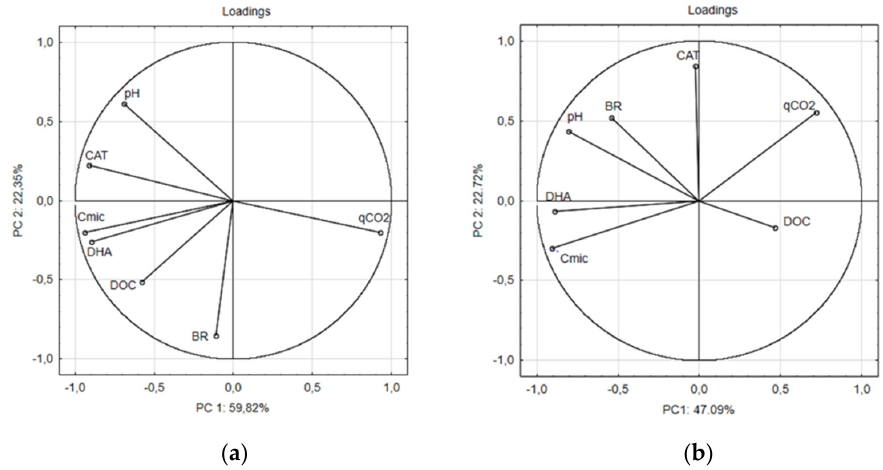
Figure 4 . Principal component analysis (PCA loadings) for variables’ parameters tested: ( a ) silty loam Abruptic Luvisol, and ( b ) sandy Brunic Arenosol.